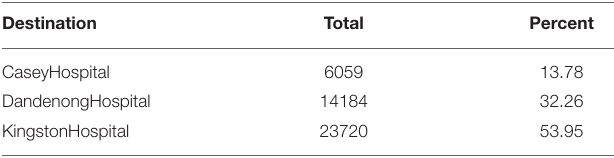
TABLE 4 | The proportion of randomly sampled addresses allocated to each rehabilitation center via the distance calculation.